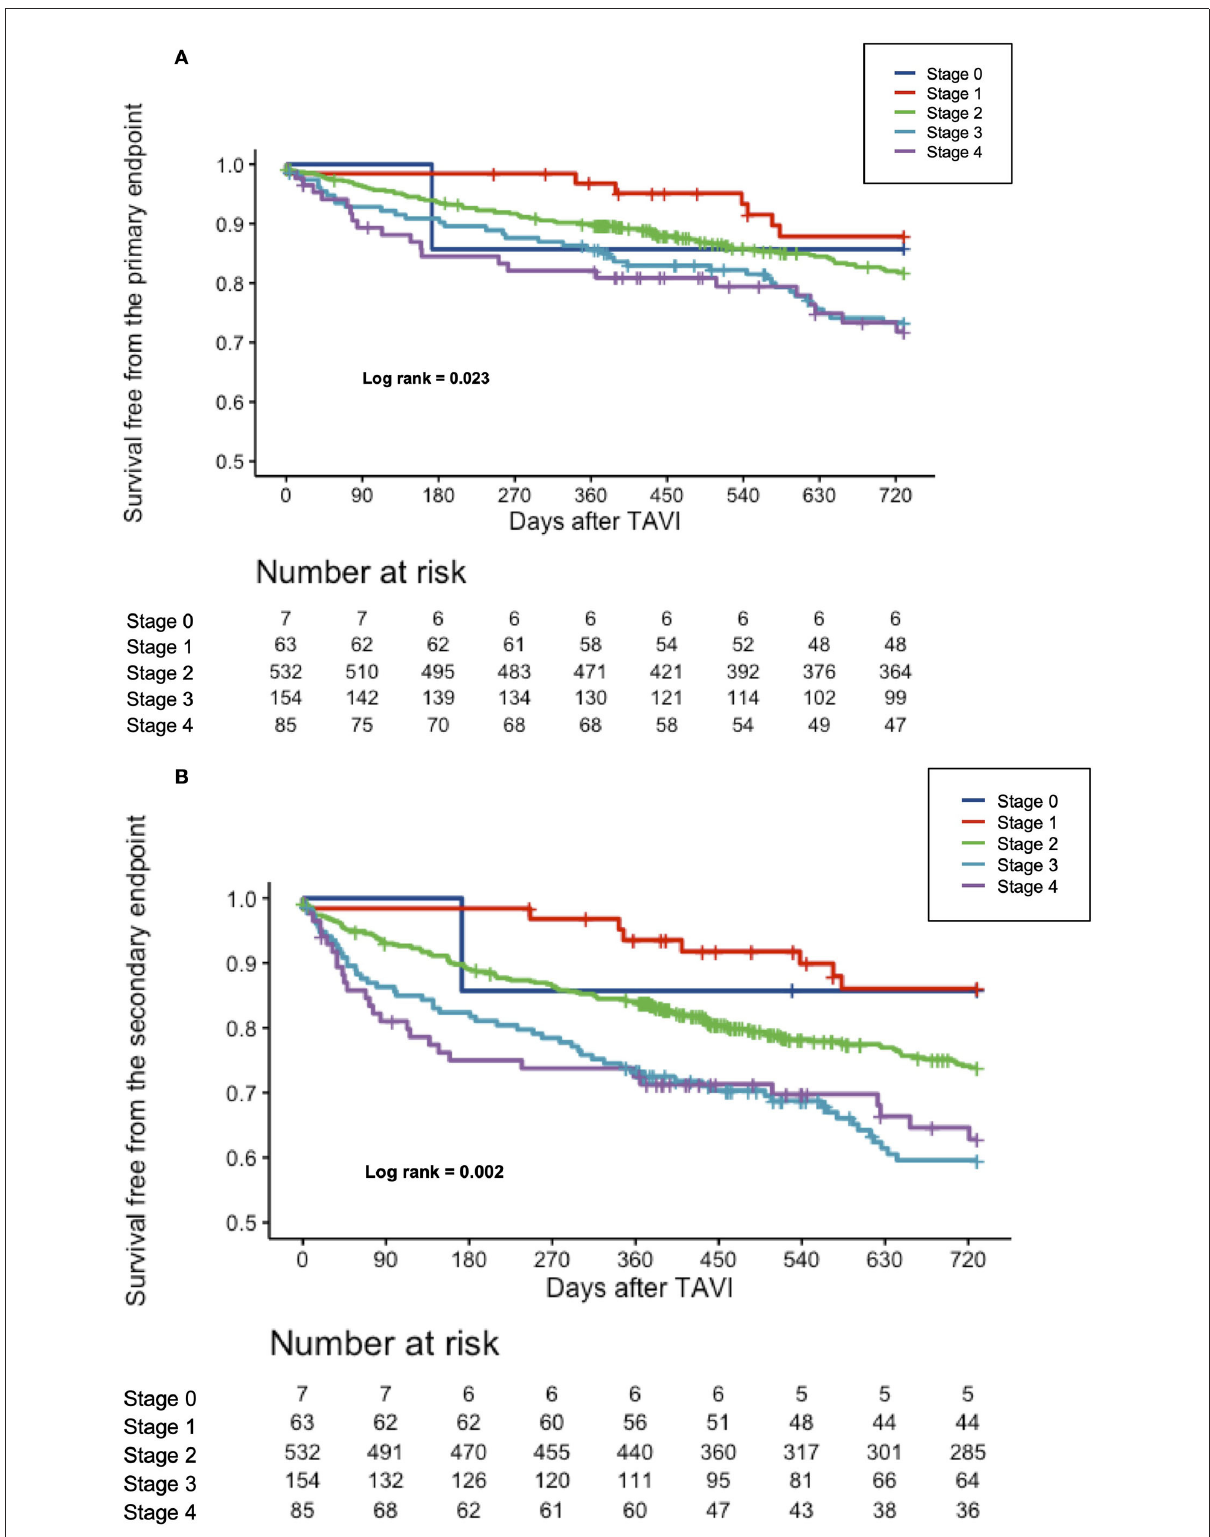
FIGURE1 (A) Cumulative incidence of all-cause mortality according to the stages of cardiac damage. Kaplan–Meier curves showing cumulative incidence of all-cause mortality according to the stages of cardiac damage. (B) Cumulative incidence of the composite all-cause mortality or rehospitalization for worsening CHF according to the stages of cardiac damage. Kaplan–Meier curves showing cumulative incidence of the composite all-cause mortality according to the stages of cardiac